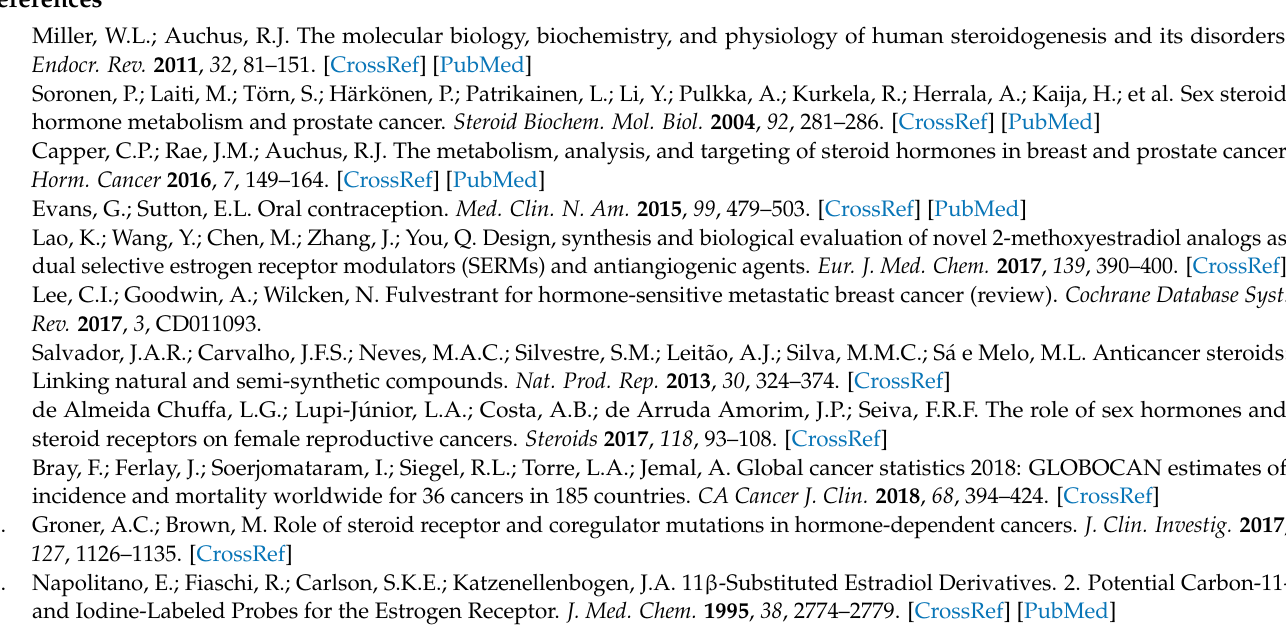
Figure S4. IR spectrum of compound 3 ; Figure S5. 1 H-NMR spectrum of compound 3 in DMSO- d 6 ; Figure S6. 13 C-NMR spectrum of compound 3 in DMSO- d 6 ; Figure S7. IR spectrum of compound 4 ; Figure S8. 1 H-NMR spectrum of compound 4 in CDCl 3 ; Figure S9. 13 C-NMR spectrum of compound 4 in CDCl 3 ; Figure S10. IR spectrum of compound 5 ; Figure S11. 1 H-NMR spectrum of compound 5 in CDCl 3 ; Figure S12. 13 C-NMR spectrum of compound 5 in CDCl 3 ; Figure S13. IR spectrum of compound 6 ; Figure S14. 1 H-NMR spectrum of compound 6 in CDCl 3 ; Figure S15. 13 C-NMR spectrum of compound 6 in CDCl 3